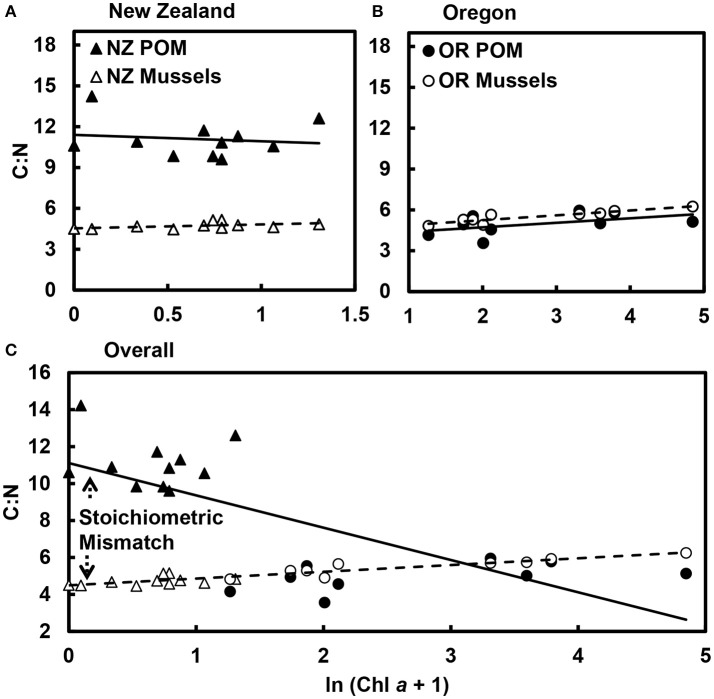
Stoichiometric mismatch in C:N between mussels and particulate organic matter (POM) declined as phytoplankton abundance increased. Mismatch was much more pronounced in (A) New Zealand (p < 0.001) than in (B) Oregon (p = 0.327). (C) Overall, as phytoplankton abundance (ln Chl a) increased, the C:N of the POM declined (R2 = 0.47, p < 0.001), whereas the C:N of the mussels increased (R2 = 0.85, p < 0.001), resulting in mismatch between consumers and their resources. Data points are mean values for each site.